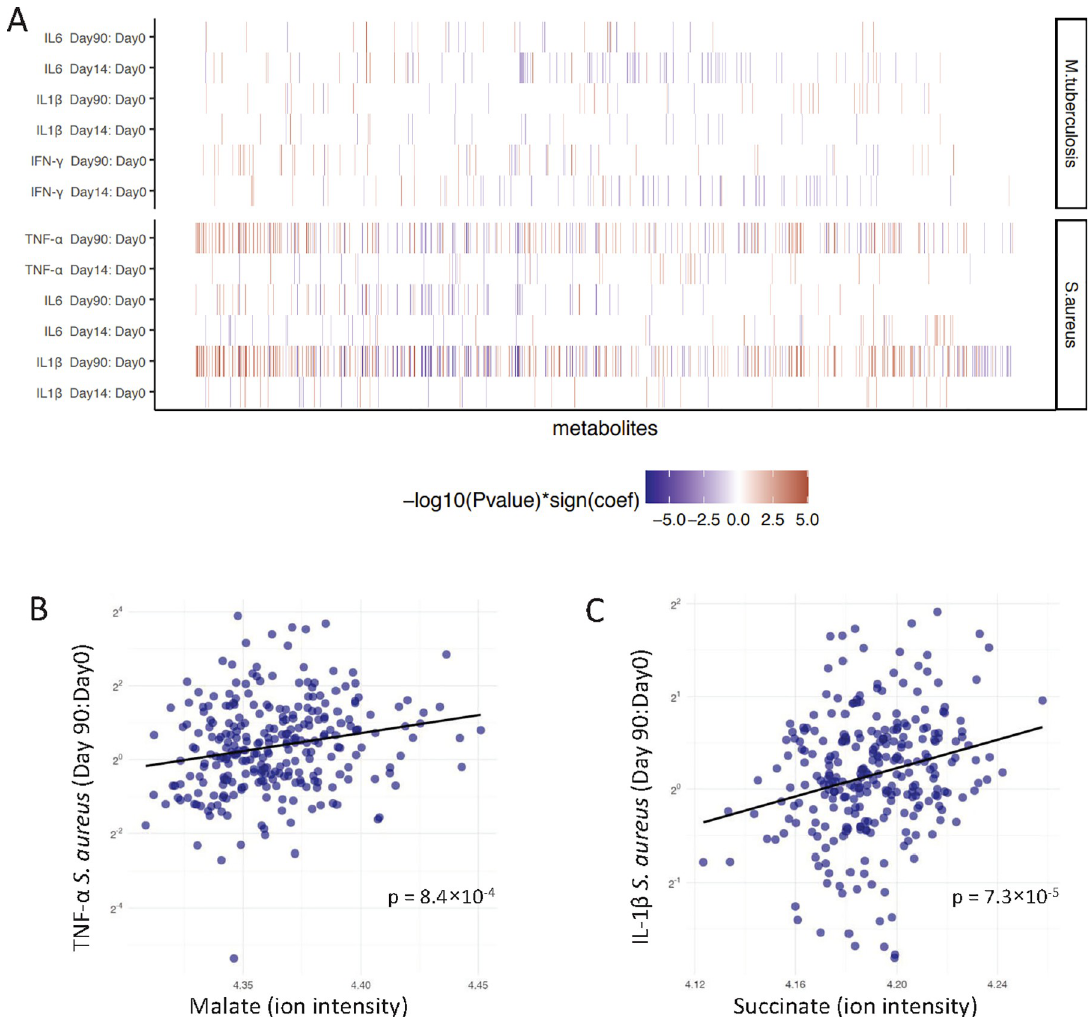
Fig 2. Association between baseline metabolites and ex vivo cytokine responses upon BCG vaccination. ( A ) Baseline metabolites were associated with fold changes of PBMC-derived S . aureus -induced IL-1 β , IL-6, and TNF- α responses and M . tuberculosis -induced IL-1 β , IL-6, and IFN- γ responses corrected for age and sex. Fold changes were calculated 2 weeks (v2, day 14) or 3 months (v3, day 90) after BCG vaccination compared to baseline (v1, day 0). Only metabolites with a significant association to one of the cytokine-stimulus pairs are depicted in this figure ( N = 777, p < 0.05). The metabolites are ordered by hierarchical clustering. Cell colors indicate significant associations as − log 10 (p-value) multiplied by the correlation coefficients from negative (blue) to positive (red). The summary statistics of top 10 associated metabolites per stimulation can be found in S2 Table. ( B ) Linear regression between malate at baseline and fold changes of ex vivo PBMC-derived S . aureus -induced TNF- α responses 3 months after vaccination. ( C ) Linear regression between succinate at baseline and fold changes of ex vivo PBMC-derived S . aureus -induced IL-1 β responses 3 months after vaccination. The metadata on study participants, metabolome, and cytokine data used to generate these figures are available at https://gitlab.com/xavier- lab-computation/public/bcg300. BCG, Bacillus Calmette–Gue´rin; PBMC, peripheral blood mononuclear